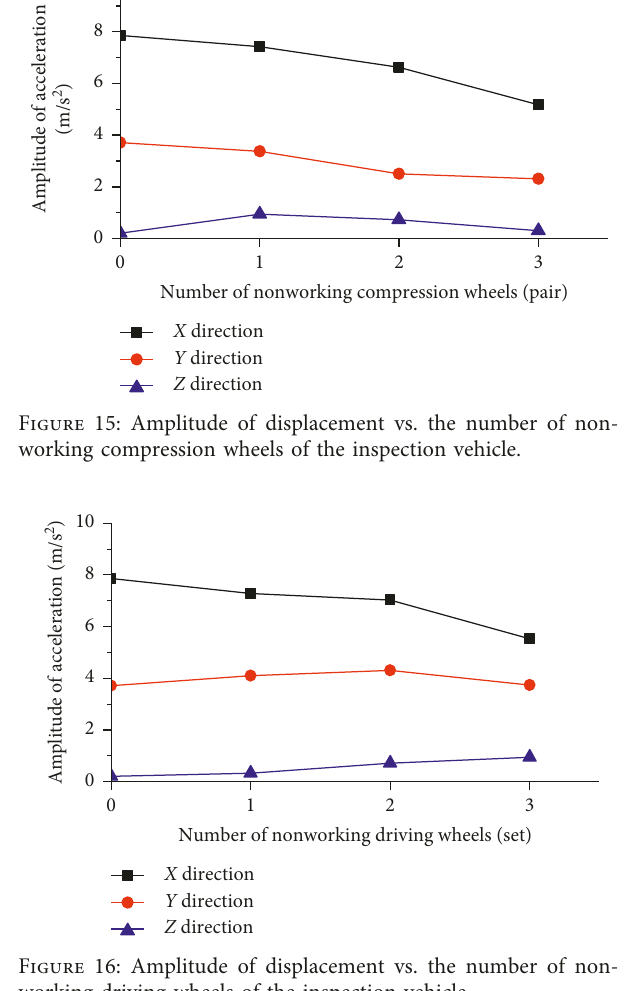
Figure 16: Amplitude of displacement vs. the number of non- working driving wheels of the inspection vehicle.